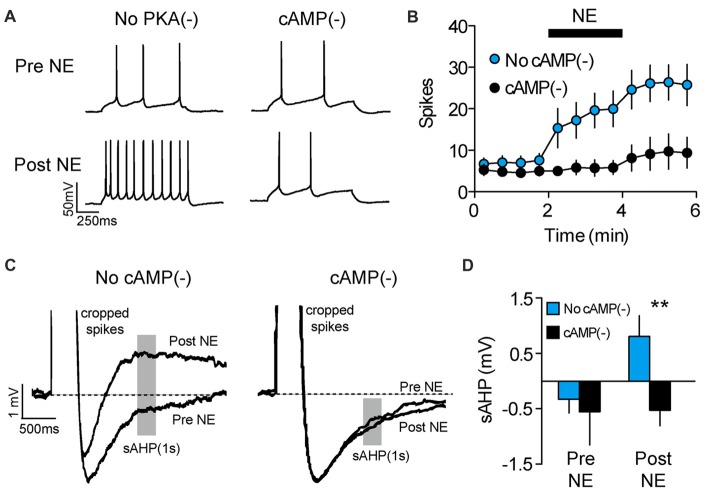
NE enhances PL-mPFC neuronal excitability via cAMP-dependent sAHP inhibition. (A) Representative waveforms showing current-evoked action potentials before (top) and after (bottom) application of NE. (B) NE increased the number of spikes per sweep, an effect that was blocked by inhibition of cAMP-dependent signaling. (C) Representative sAHP waveforms before and after application of NE. (D) NE reversed the sAHP into a slow afterdepolarization, an effect that was blocked by inhibition of cAMP-dependent signaling. Line and bar graphs represent the mean ± SEM. NE, norepinephrine; cAMP(−), inhibitor of cAMP-dependent signaling (Rp-2’-O-MB-cAMPs); sAHP, slow afterhyperpolarization; **p < 0.01 vs. control.